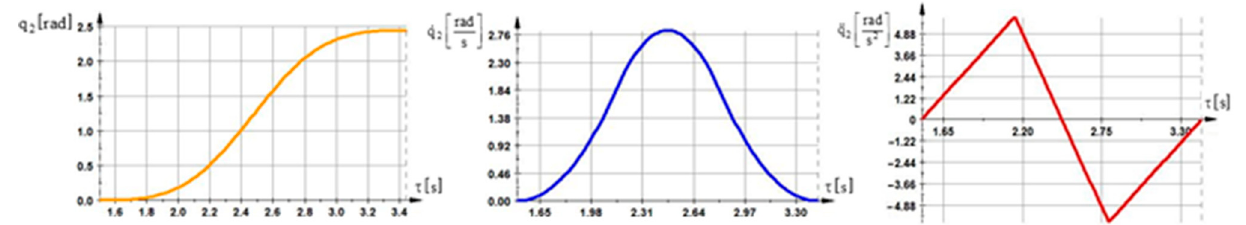
Figure 6. Expressions that vary with time for the generalized coordinates, speeds, and accelerations for kinetic joint j = 2.